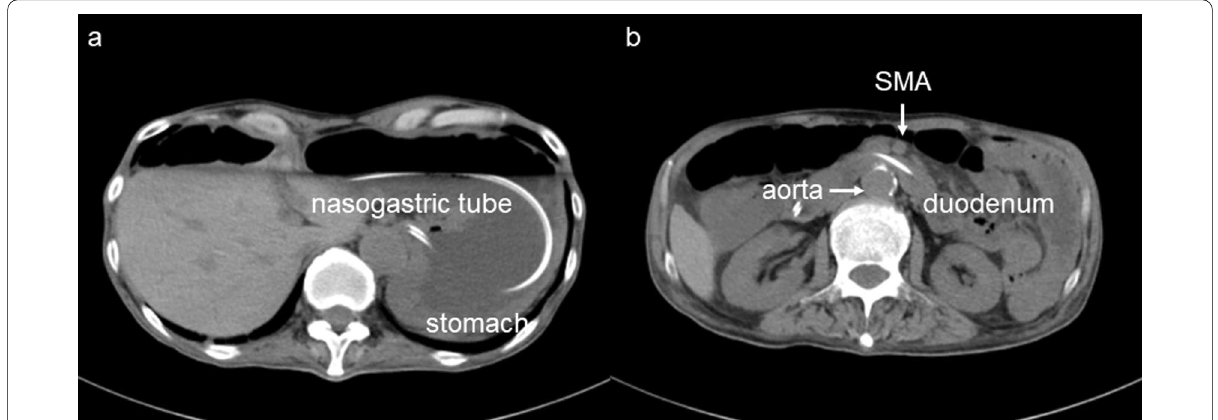
Fig. 1 Abdominal computed tomography findings. a The stomach is dilated because of obstruction of the duodenum. b The third portion of the duodenum is compressed between the SMA and